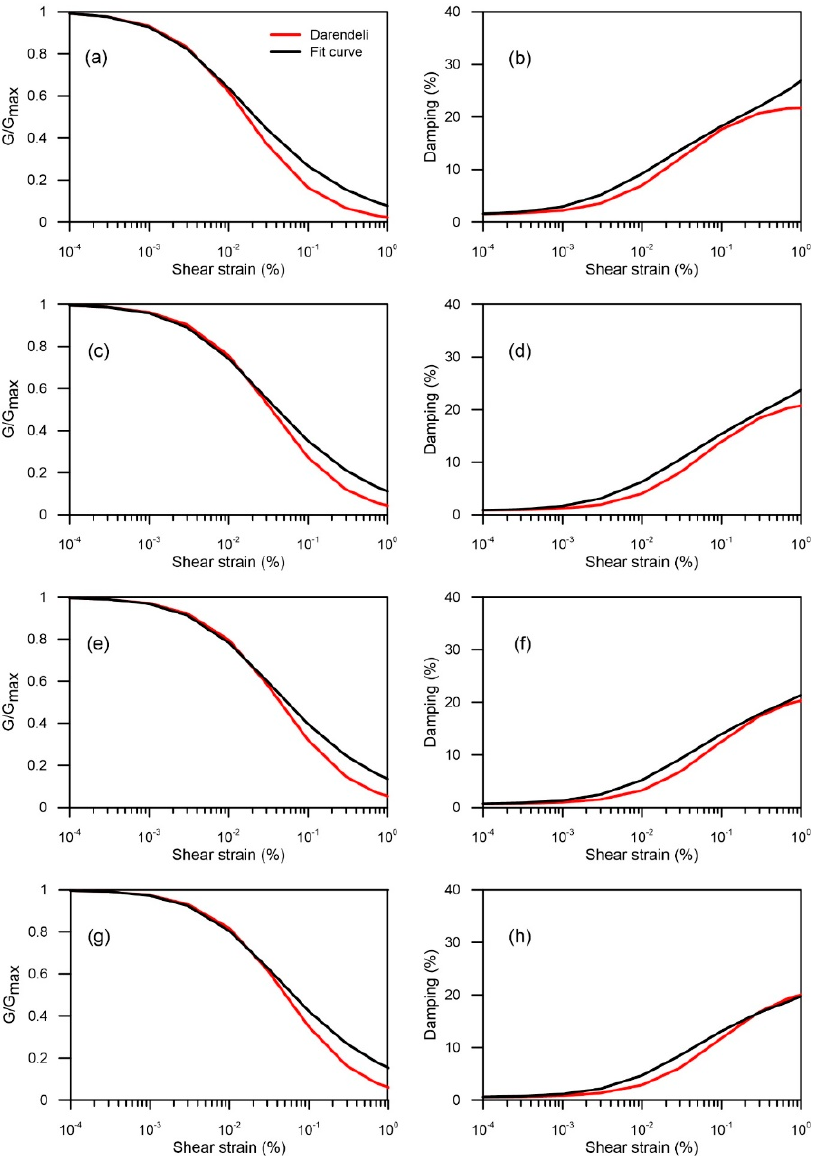
Figure 2. Modulus reduction and damping versus strains curves ( a , b ) 2.0 m ( c , d ) 10.0 m ( e , f ) 20.0 m ( g , h ) 30.0 m.